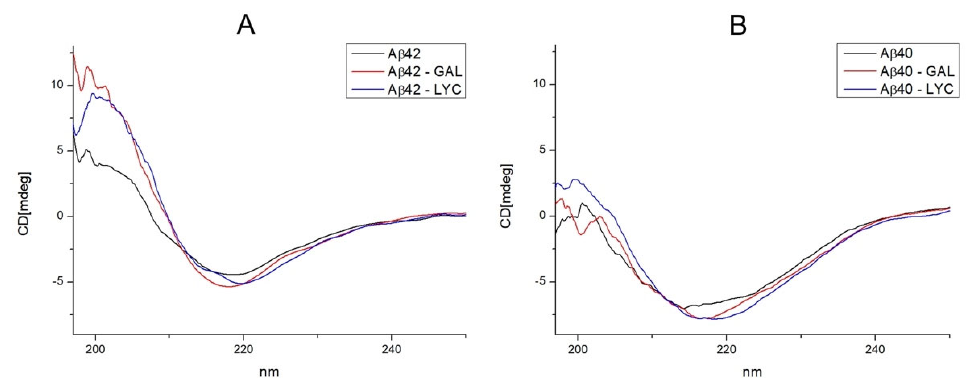
Figure 5. CD spectra of A β 42 ( A ) and A β 40 ( B ) in absence (black lines) and in presence of 0.8 GAL (red lines) and LYC (blue lines) eqs. A β 42/A β 40 concentration 3 µ M, GAL concentration 2.4 µ M, LYC concentration 2.4 µ M, phosphate buffer 1 mM, T = 298 K.